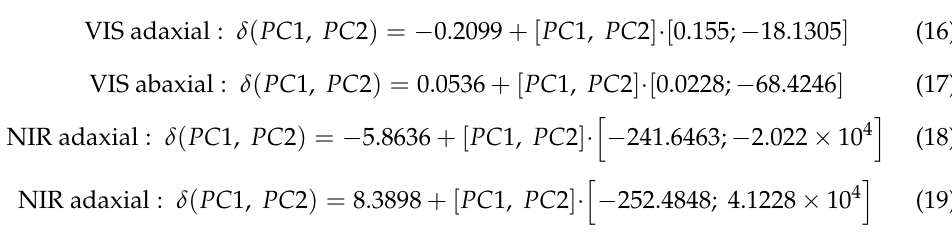
Leaf Part Spectra